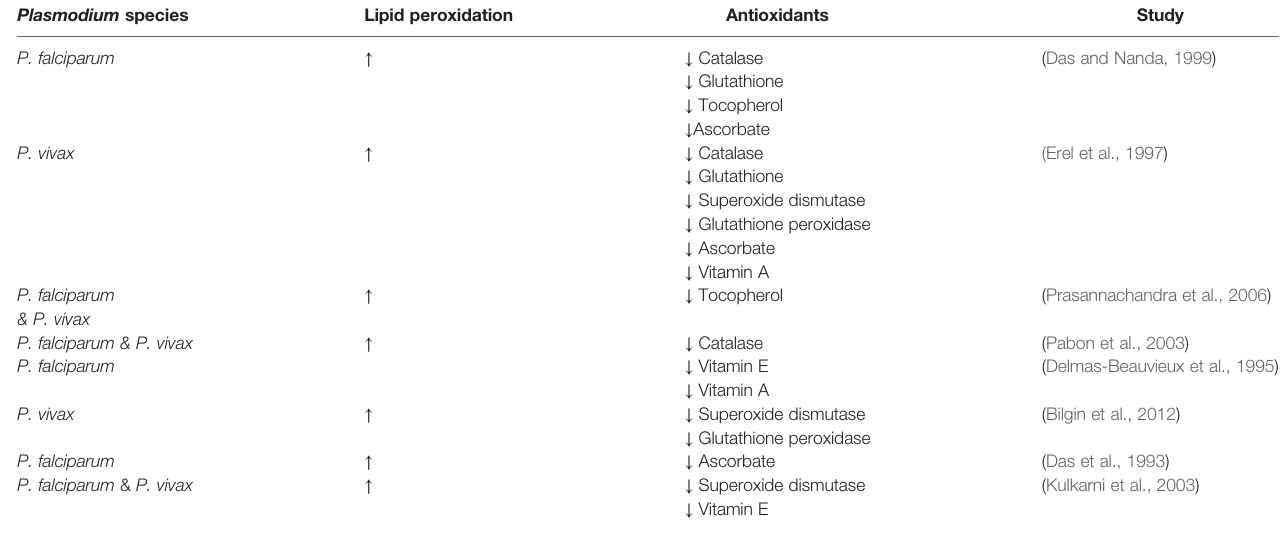
TABLE 1 | Malaria patients have signi fi cantly increased lipid peroxidation and decreased levels of antioxidants. Plasmodium species Lipid peroxidation